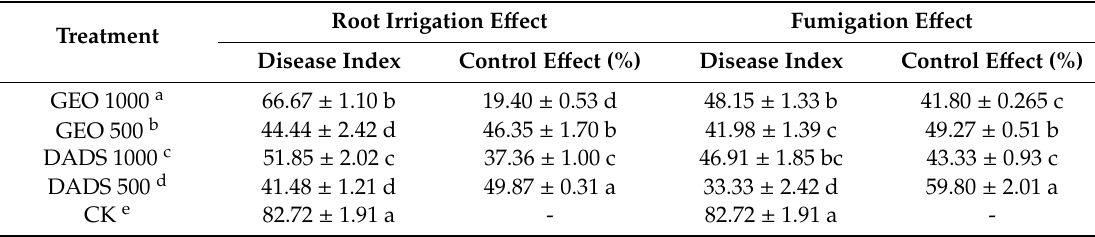
Table 2. The control e ffi cacy of the garlic essential oil and diallyl disulfide (DADS) treatments against tobacco black shank.